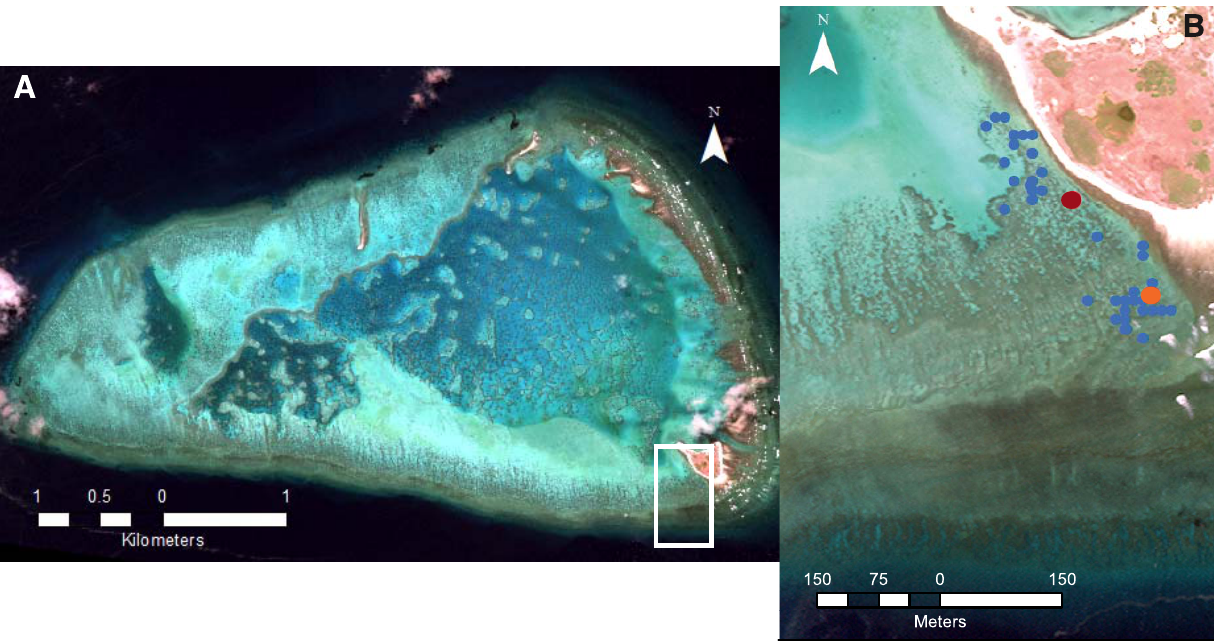
Figure 1. Study site. (A) One Tree Island and reef. (B) Reef flat study site showing sampling locations. The main slack water sampling site is shown in red and second slack water site shown in orange. Flow respirometry start and end points are shown in blue. Image data processed by the University of Wollongong. Worldview 2 data provided by Digital